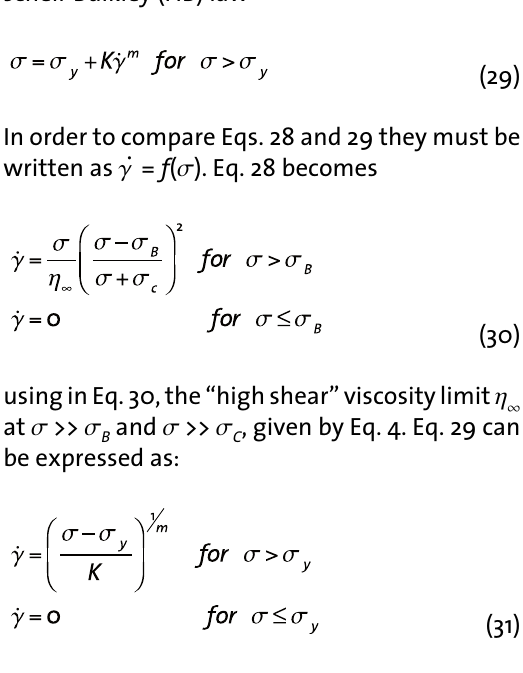
Figure 8 (left): Relative viscosity versus reduced time t = k t. Effect R A0 of applying a reduced stress s / s = s , following a rest A c RA period ( s = 0, duration R0 t ). Curve Index ( s ; s ) R0 R0 Rm means that s = s for R R0 0 < t < t and s = s for R R0 R Rm t > t (“rest” corresponds to R R0 (0; 0), Bifurcation appears for s = s = 1.08, value in R RB and s . Dura- between s R1 R2 tion: t = 200, same values R0 of other NLS-parameters as for Figure 4). Figure 9: Evidence of the bifurcation at s = s under applying a R RB stress after a rest period (duration t = 8·10 3 ). Reju- R0 venation under shear rate is associated to variations under s < s (same SNL- R RB parameter values than for Figure